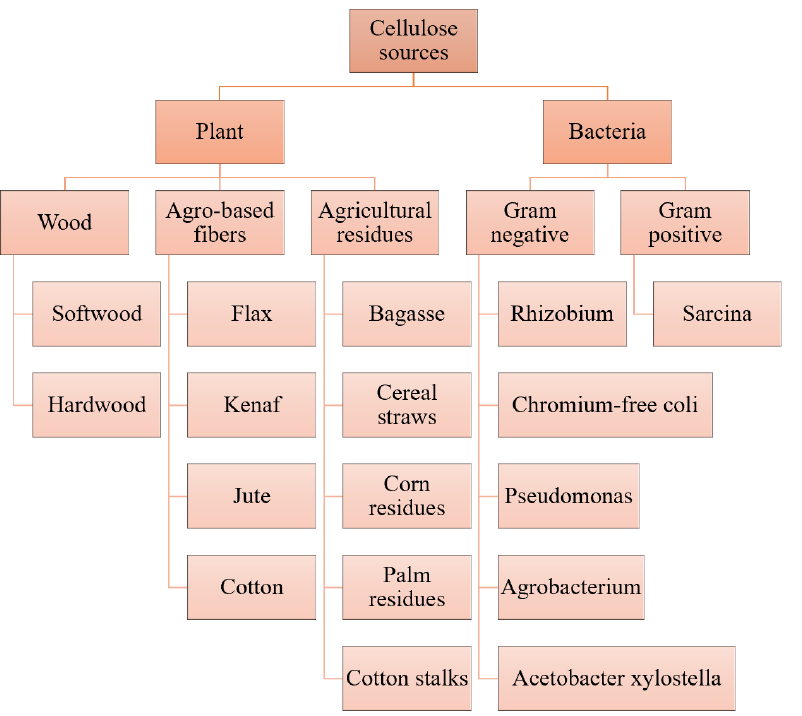
Figure 3. Fiber classification by source: plant and bacteria.